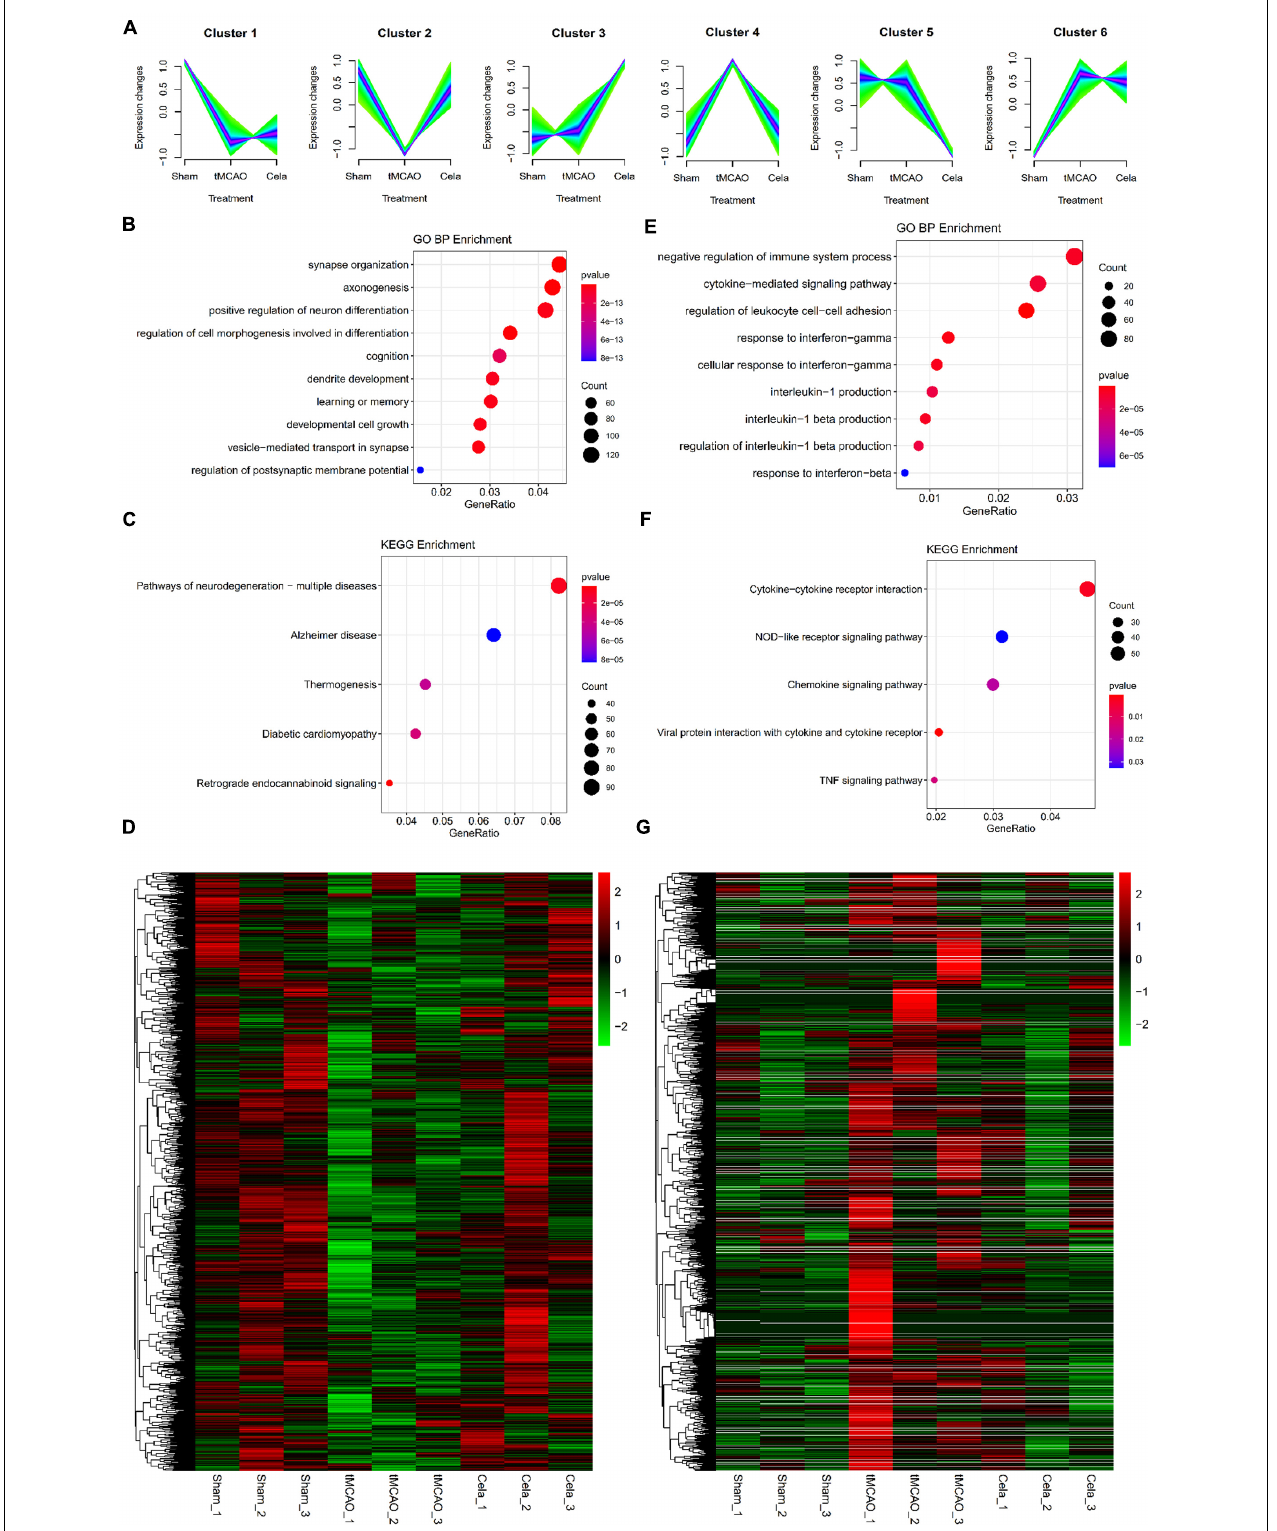
FIGURE 3 | (A) Six clusters of mRNAs among the three groups by Mfuzz analysis. (B–D) The enrichment results of GO analysis, KEGG pathway and the heatmap of up-regulated genes in mRNA cluster 2. (E–G) The enrichment results of GO analysis, KEGG pathway and the heatmap of down-regulated genes in mRNA cluster 4.